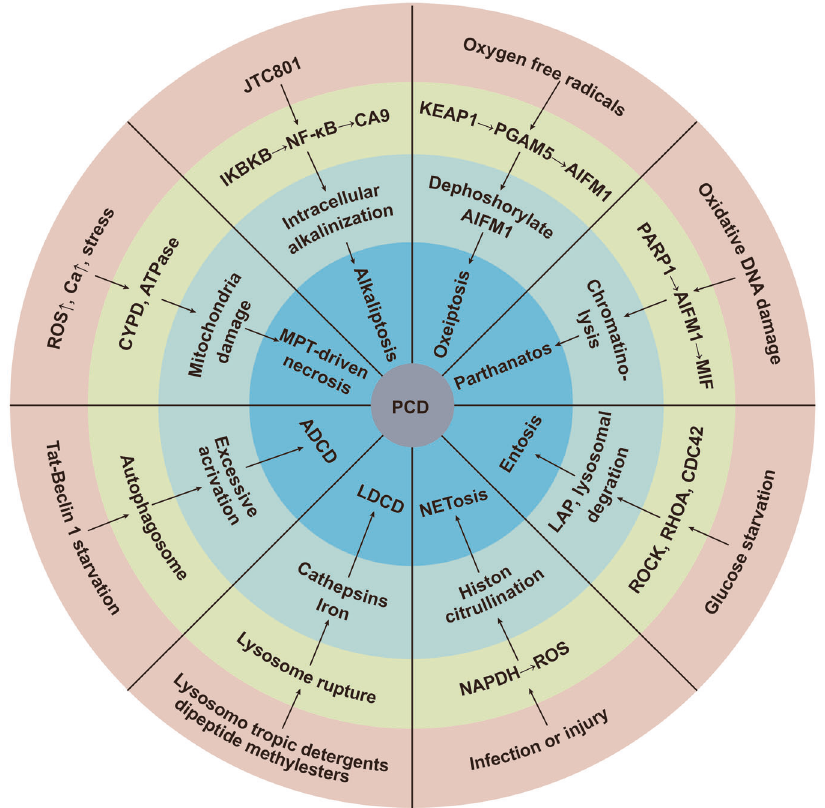
Fig. 3 Molecular mechanisms of eight uncommon PCDs. MPT-driven necrosis, ADCD, LDCD, NETosis, Entosis, parthanatos, oxeiptosis and alkaliptosis.